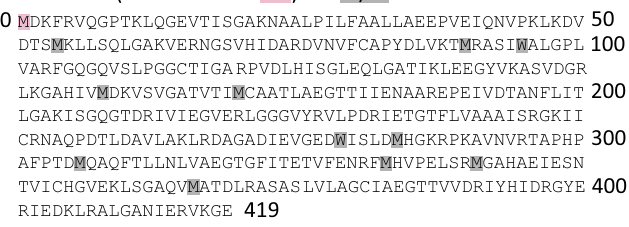
MTTNTHTLQIEEILELLPHRFPFLLVDRVLDFEEGRFLRAVKNVSVNEPF FQGHFPGKPIFPGVLILEAMAQATGILAFKSVGKLEPGELYYFAGIDEAR FKRPVVPGDQMIMEVTFEKTRRGLTRFKGVALVDGKVVCEATMMCARSRE A MIKQRTLKRIVQATGVGLHTGKKVTLTLRPAPANTGVIYRRTDLNPPVDF PADAKSVRDTMLCTCLVNEHDVRISTVEHLNAALAGLGIDNIVIEVNAPE IPIMDGSAAPFVYLLLDAGIDELNCAKKFVRIKETVRVEDGDKWAEFKPY NGFSLDFTIDFNHPAIDSSNQRYAMNFSADAFMRQISRARTFGFMRDIEY LQSRGLCLGGSFDCAIVVDDYRVLNEDGLRFEDEFVRHKMLDAIGDLFMC GHNIIGAFTAYKSGHALNNKLLQAVLAKQEAWEYVTFQDDAELPLAFKAP